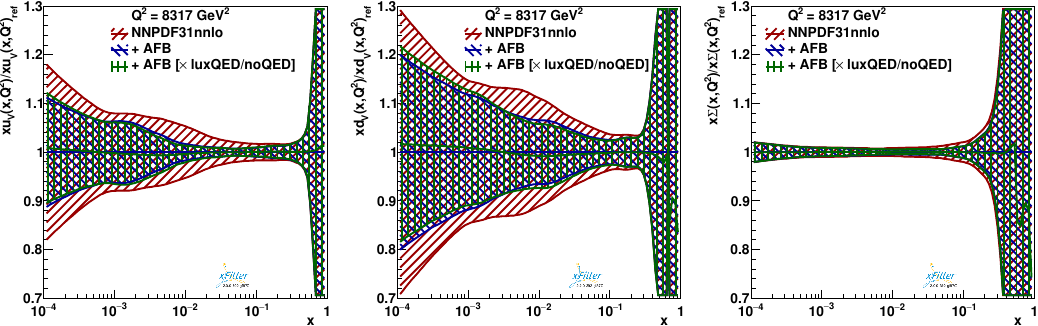
Figure 9 . Pro(cid:12)led curves obtained with the NNPDF3.1nnlo and its central value predictions rescaled with a K-factor to match the NNPDF31 nnlo as 0118 luxqed predictions. The pseudodata corresponds to an integrated luminosity of 3000 fb (cid:0) 1 .